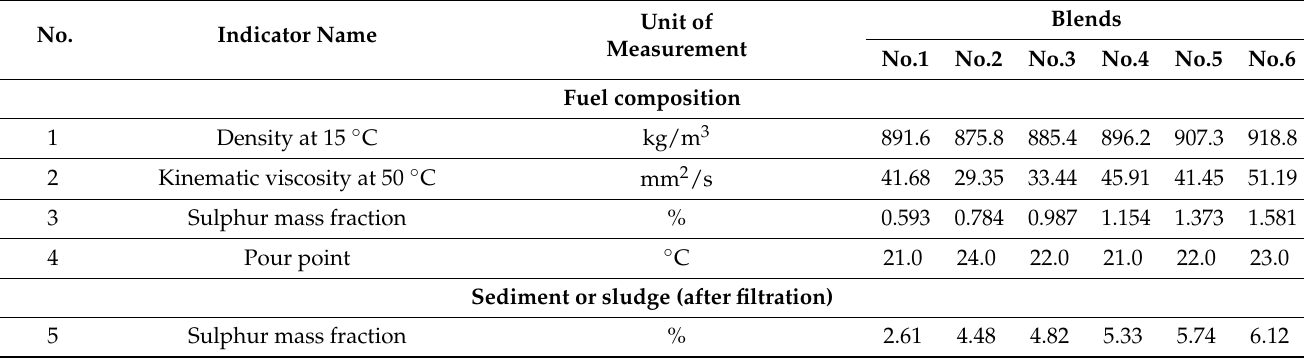
Table 4. Deasphaltisate quality and sulphur content in the